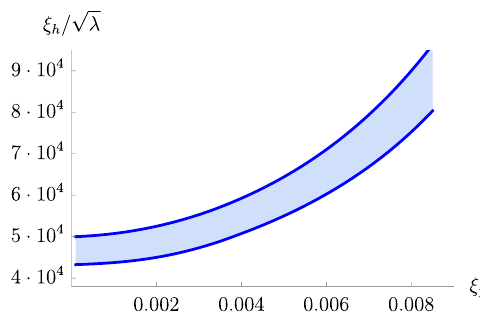
Figure 9 . The parameter region for which the amplitude and the tilt of the scalar spectrum lie in the observationally allowed region, see [42] for